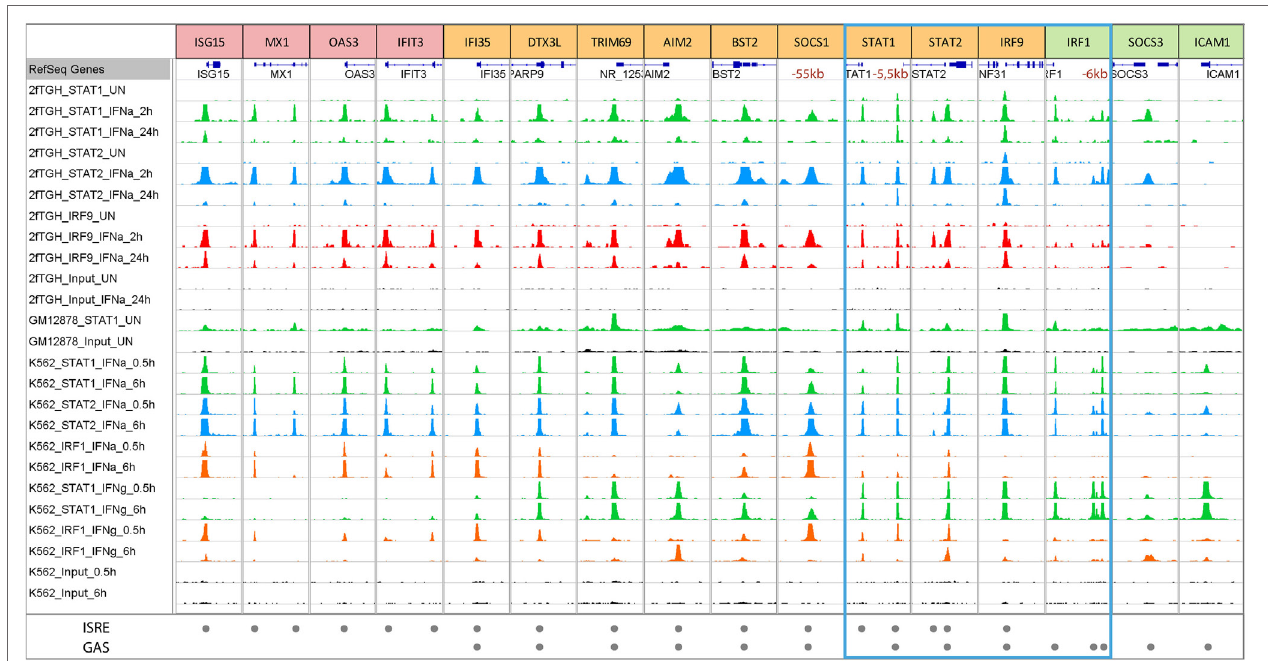
FiGUre 4 | Representative modes of STAT1, STAT2, IRF9, and IRF1 binding to ISRE and GAS-containing ISGs in GM12878, K562, and 2fTGH cells treated with or without IFN-I or IFN-II. To further study genome-wide binding of STAT1, STAT2, IRF9, and IRF1, a ChIP-seq dataset from K562 cells treated with IFN α or IFN γ for 0.5 or 6 h and GM12878 cells used as a control were retrieved from the ENCODE database (GSE31477) and compared to our recently dataset from 2fTGH cells treated with or without IFN α for 2 and 24 h (unpublished data). Antibodies used in given experiments are indicated in the left panel and by color of the track—STAT1— green, STAT2—blue, IRF9—red, and IRF1—orange. Tracks derived from input sequencing are indicated in black. The bottom panel indicates ISRE or/and GAS sequences located under the peaks (see also table 1 ). According to DNA motifs, ISGs can be divided into three groups: only ISRE-containing genes (examples are presented in red boxes—ISG15, MX1, OAS3, and IFIT3), only GAS-containing genes (examples in green boxes—IRF1, SOCS3, and ICAM1), and genes with both sequences (examples in yellow boxes—IFI35, DTX3L, TRIM69, AIM2, BST2, SOCS1, STAT1, STAT2, and IRF9). The blue frame marks components of ISGF3, GAF, and IRF1. Each group of genes displays differences in binding after IFN stimulation. ISRE-only genes show strong binding of components of ISGF3 (STAT1, STAT2, and IRF9) after IFN α , as well as IRF1 after IFN α and IFN γ , but no binding of STAT1 after IFN γ treatment. On the other hand, GAS-only genes demonstrate strong binding of STAT1 and STAT2 (components of GAF and GAF-like complexes) after IFN γ and IFN α treatment. The third group consists of ISRE + GAS composite-site containing ISGs, which display binding of all the components in response to both types of IFNs pointing to the possible cooperation and mechanism of co-binding of ISGF3, GAF and IRF1 for optimal gene expression. Abbreviations: IFN, interferon; STAT, signal transducer and activator of transcription; IRF, interferon regulatory factor; ISGF3, interferon-stimulated gene factor 3; GAF, γ -activated factor; ISRE, interferon-stimulated response element; GAS, γ -activated sequence; ISG, interferon-stimulated